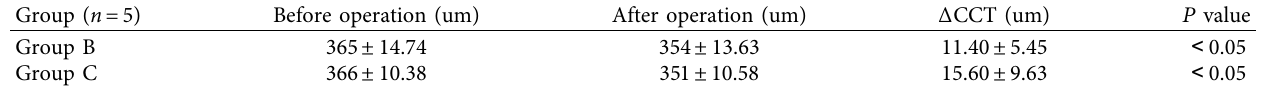
Figure 2: Postoperative representative slit lamp microscope images of group B and group C. (a) One month after the operation, the boundary of the corneal stromal lens in group B was obvious and the edge was irregular (white arrow). (b) The boundary in group C lens was faintly visible, and the edge was regular (white arrow). (c, d) Three months after the operation, the corneal stromal lenses in group B and C were basically fixed to the adjacent corneal stroma without obvious boundary. Table 1: CCT data before and 3 months after lens